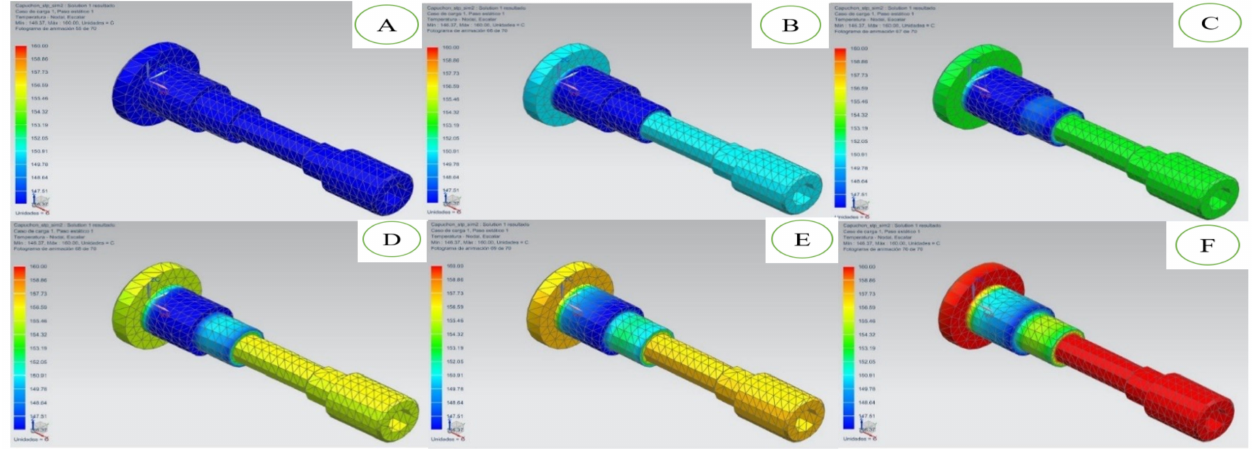
Figure 6. Thermal sequence of polyethylene HDPE from ( A – F ) related to the time of